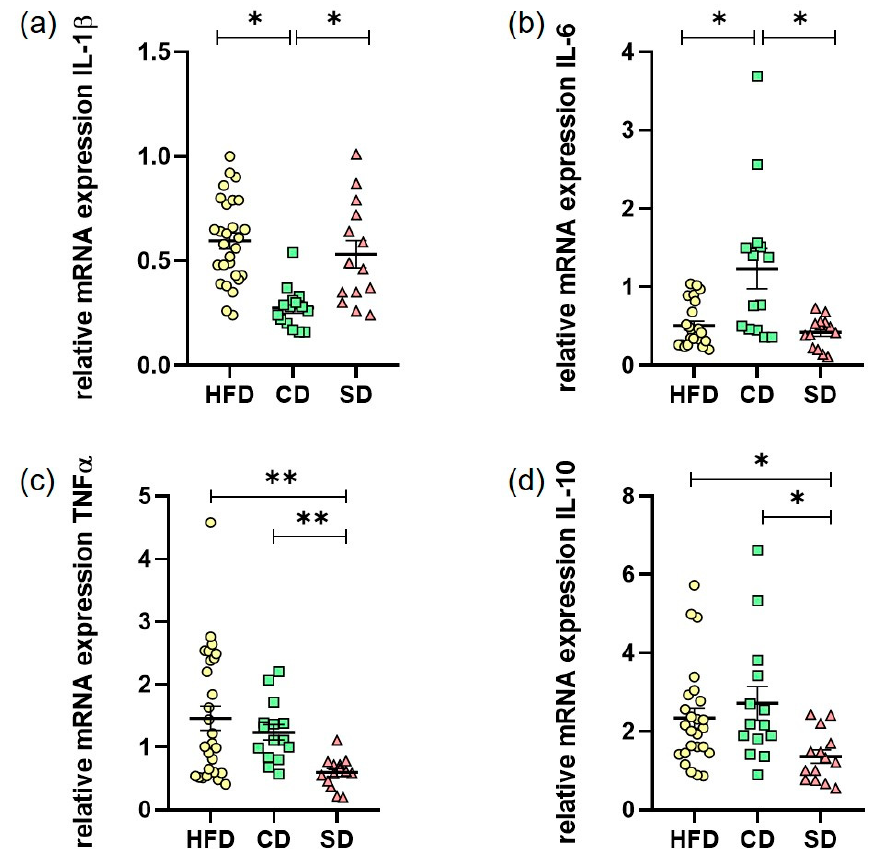
Figure 7. ( a ) Hepatic mRNA expression in the high fat diet (HFD), control diet (CD) or standard diet (SD) group of IL-1 β (HFD: n = 28, CD: n = 14, SD: n = 14); ( b ) Hepatic mRNA expression of IL-6 (HFD: n = 24, CD: n = 15, SD: n = 14); ( c ) Hepatic mRNA expression of TNF α (HFD: n = 28, CD: n = 15, SD: